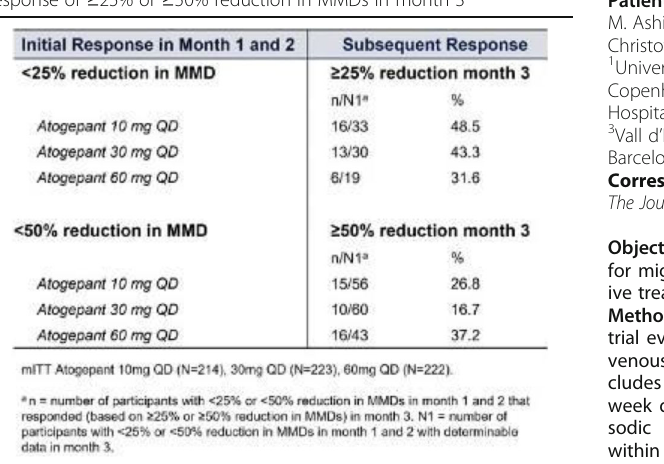
Table 2 (abstract P110). Proportion of participants with an initial inadequate response in month 1 and 2 that achieved a subsequent response of ≥ 25% or ≥ 50% reduction in MMDs in month